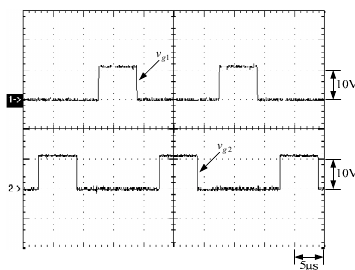
Figure 23. Waveforms pertaining to current balancing at the minimum load: (1) v S 1 ; (2) v S 2 ; (3) i L 1 ; and (4) i L 2 .